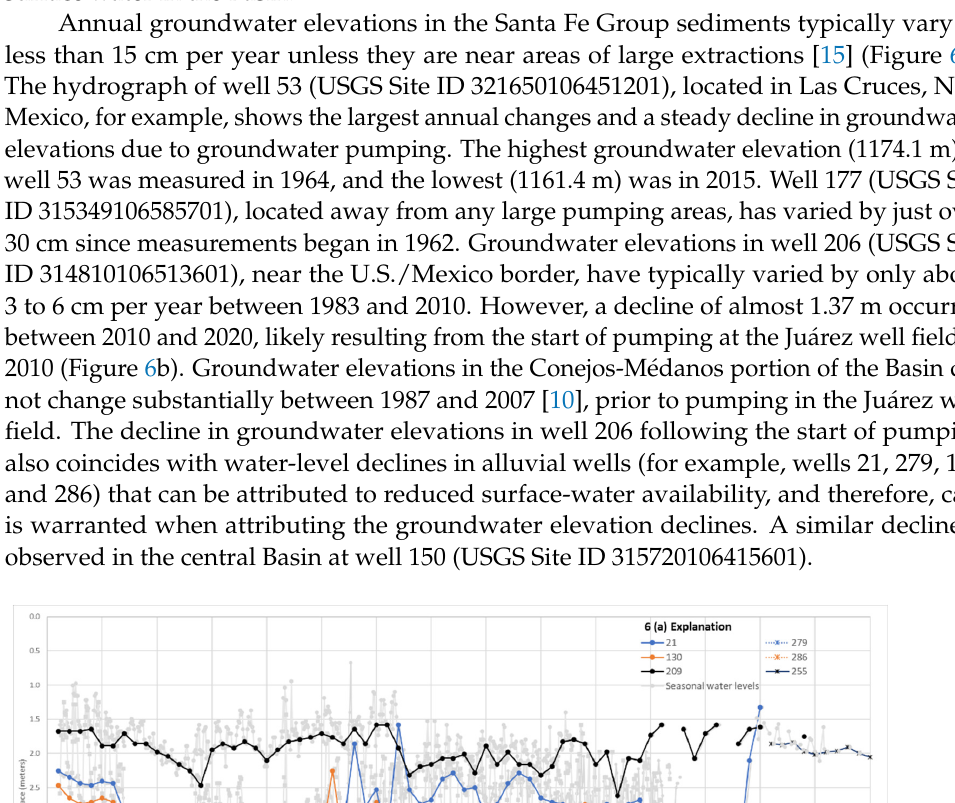
Figure 6. Groundwater levels, 1945–2020. ( a ) Depth to water measured in piezometers screened in the Rio Grande alluvium; ( b ) groundwater elevation measured in wells screened in the Santa Fe Group sediments at depths greater than 90 m below land surface. Well locations are shown in Figure 2. Data from USGS (2021) [18]. 5. Water Chemistry Spatial patterns and relations between water chemical and isotopic data are useful for determining recharge sources, direction of flow, and geochemical processes [5,13]. As